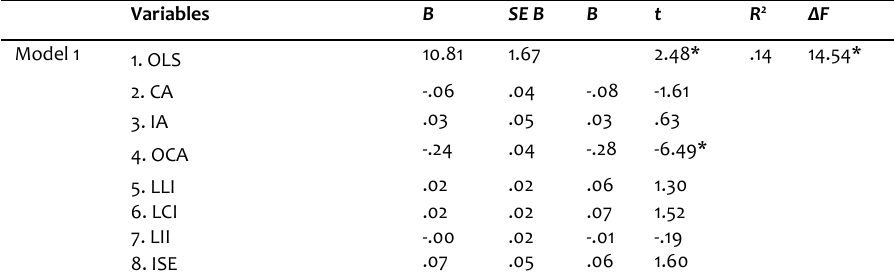
Table 6. Summary of the MLR Analysis for the Predictors of